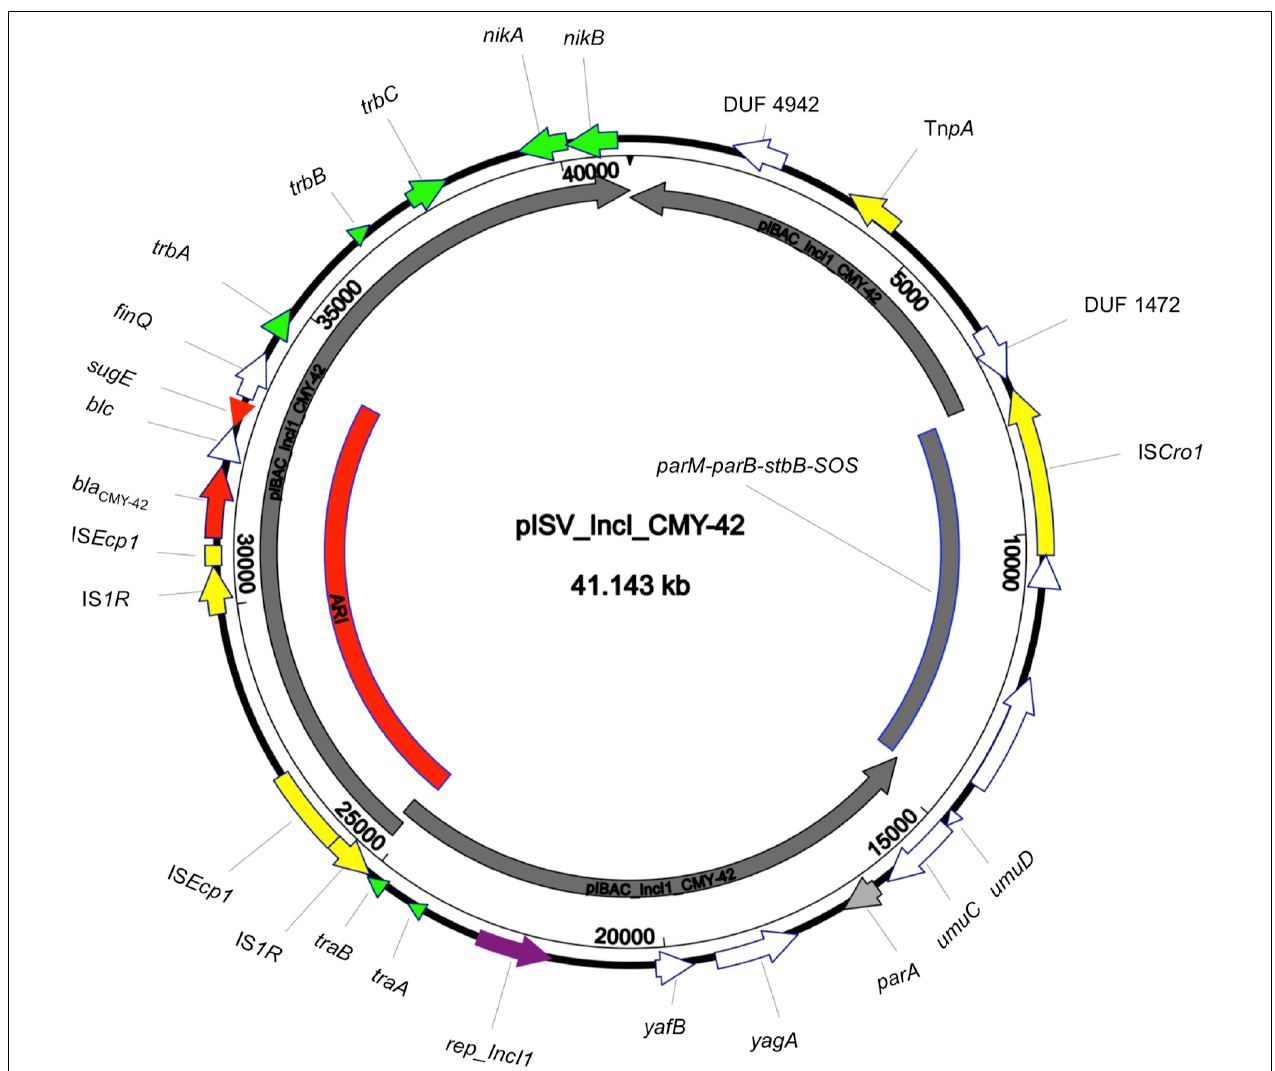
FIGURE 2 | Circular map of pISV_IncI_CMY-42 plasmid compared to pIBAC_IncI_CMY-42 (inner most gray circular box); green arrows represent conjugal transfer system of the plasmid, red arrows represent antibiotic resistance genes, yellow arrows/boxes represent complete/truncated mobile elements, white arrows represent hypothetical proteins, purple arrow represents the replication protein rep_IncI. Further more, the red-arced box represents the plasmid Antibiotic Resistance Island (ARI).